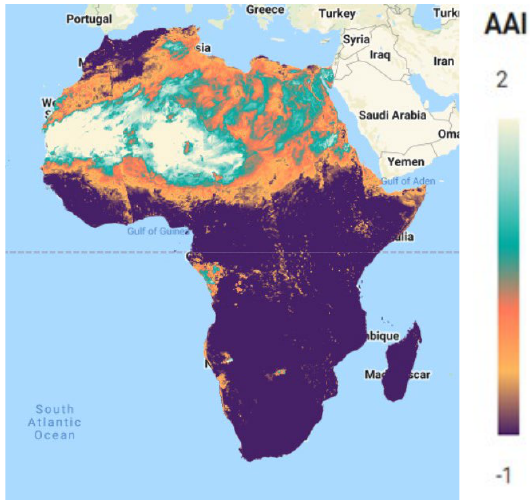
Fig. 2. Aerosol movement from 1 st – 3 rd June of 2020 Between the 4 th and 6 th of June 2020, the dust plume expanded horizontally and covered a wider range.